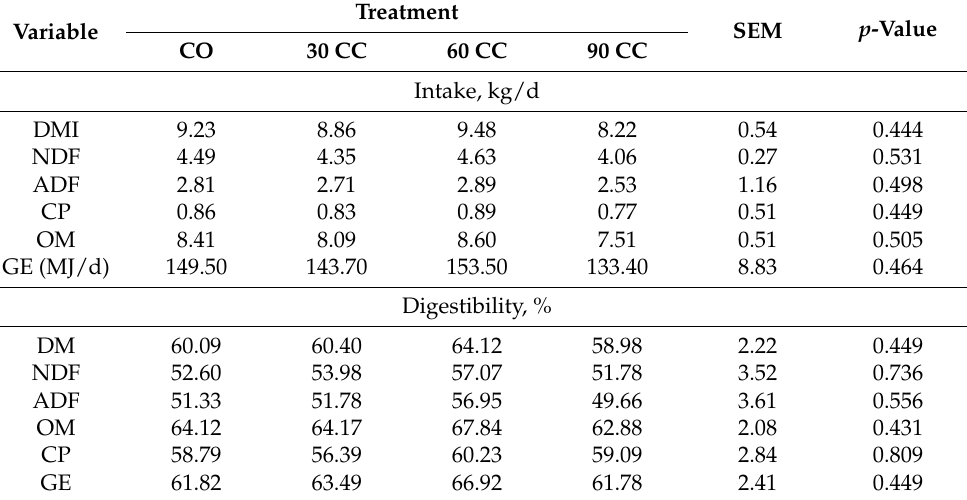
Table 2. Effect of increasing Cymbopogon citratus levels on the dry matter, organic matter, fibre fractions, crude protein, and gross energy intakes, and their digestibilities observed in the experimental heifers fed a high-forage diet. Treatment Variable